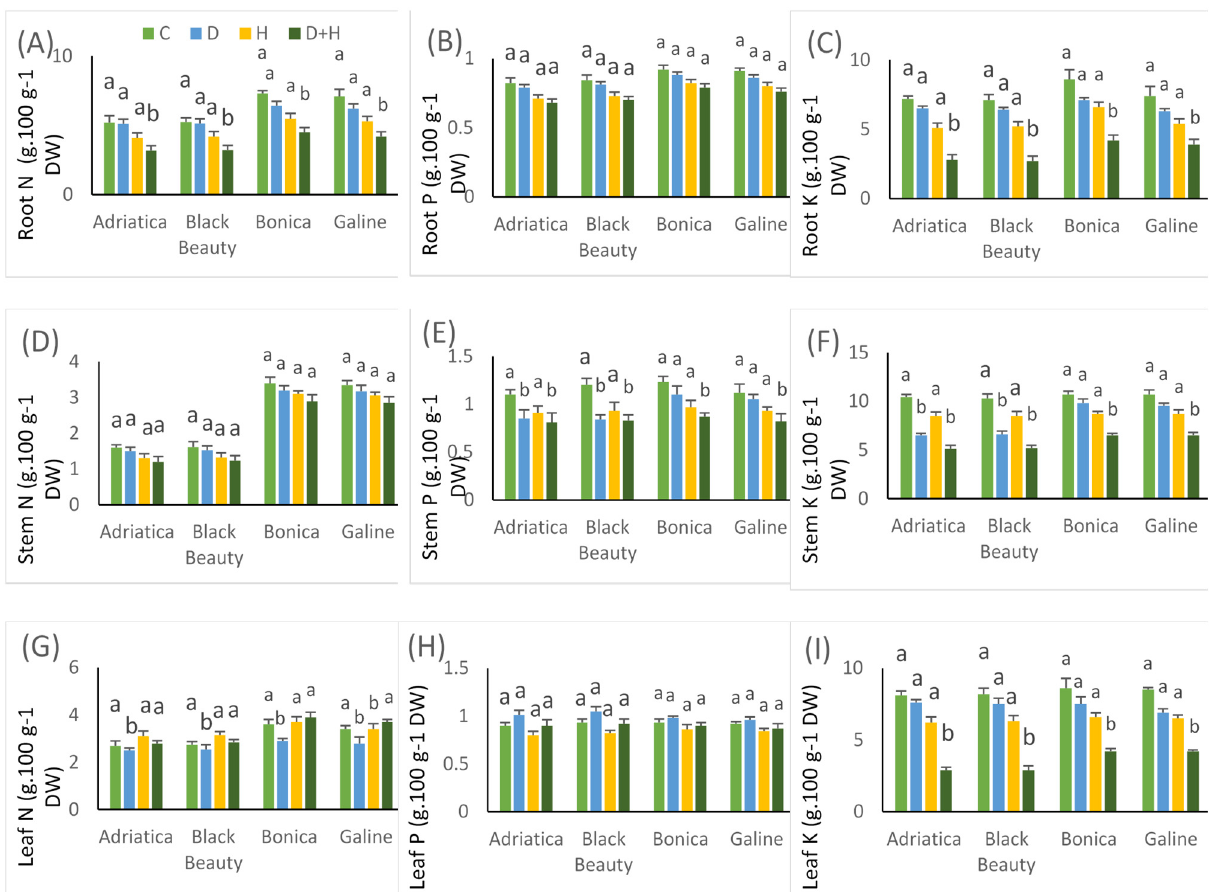
Figure 8. Changes in Nutrient contents in roots: ( A ) nitrogen, ( B ) phosphorus, and ( C ) potassium; in stems ( D ) nitrogen, ( E ) phosphorus, and ( F ) potassium, and in leaves ( G ) nitrogen, ( H ) phosphorus, and ( I ) potassium of four eggplant cultivars subjected to drought, heat, and drought + heat stresses. Data presented are the means ± SE ( n = 5). Significant dissimilarities are shown by different lower-case letters between treatments ( p ≤ 0.05) based on Tukey’s test. (C, control; H, heat stress; D, drought stress; H + D, heat + drought stresses).